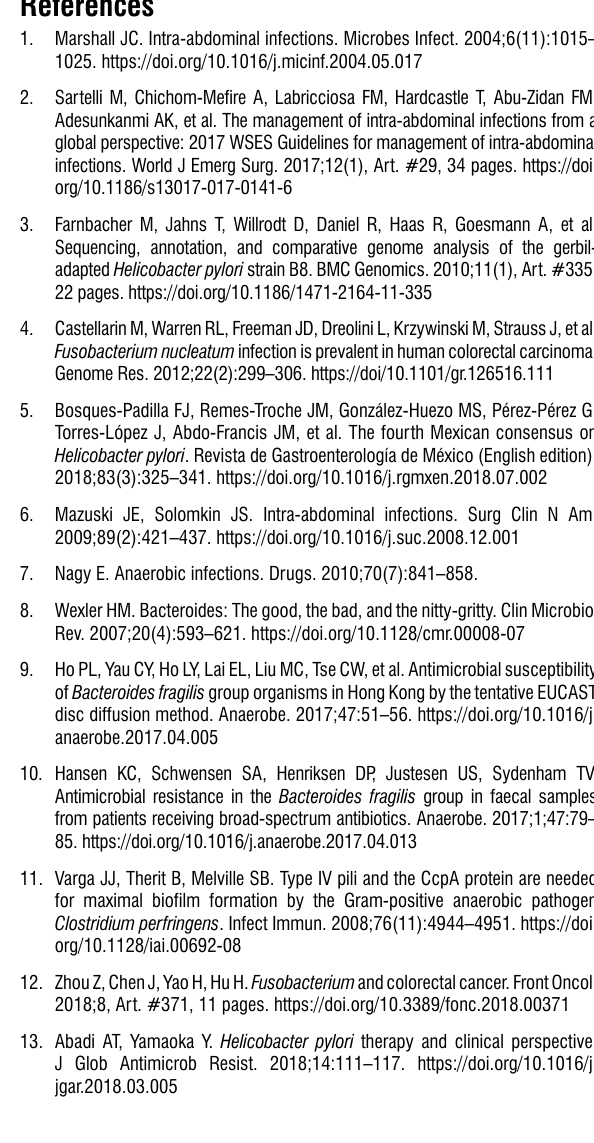
Overall summary of the